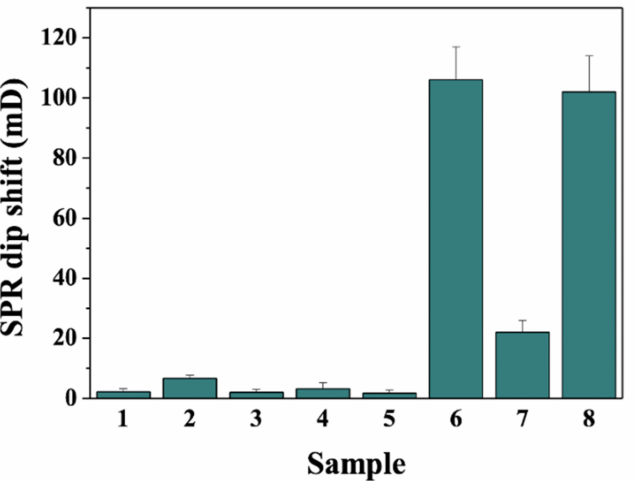
Figure 5. Selectivity of the method toward 1 nM A β 16 (bar 1), 1 nM A β 42 (bar 2), 10 ng/mL HSA (bar 3), 1 nM beta-secretase (bar 4), 5 nM avidin (bar 5), 1 pM A β 40 (bar 6) and the mixture of 1 nM avidin and 1 pM A β 40 by one-step (bar 7) or two-step (bar 8) magnetic